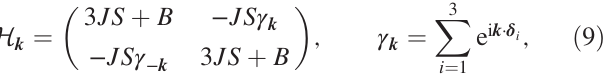
FIG. 2. Single- and two-magnon sectors in honeycomb ferro- magnets along high-symmetry paths of the Brillouin zone. At B ¼ 0 , the harmonic single-particle energies [white lines; cf. Eq. (12)] overlap with the two-magnon density of states [color plot; cf. Eq. (27)]. Dark blue (yellow) color indicates zero (maximal) two-magnon density of states. The red rectangle around the Dirac cone at the K point indicates the momentum and energy window shown in Fig. 4. For increasing fields, the single-particle energies are shifted upwards in energy by B , while the two-magnon continuum is shifted by 2 B . Hence, for large enough fields, the continuum is shifted past the single-particle energies. In particular, the Dirac cones at the K and K 0 points leave the continuum at B= ð JS Þ ¼ 1